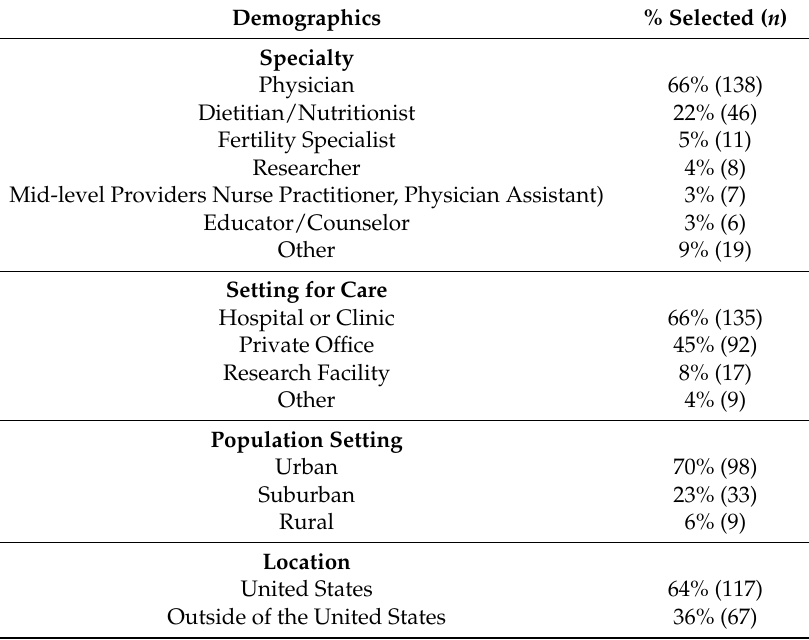
Table 2. Professional characteristics of the health care providers from survey collecting data on multidisciplinary PCOS treatment